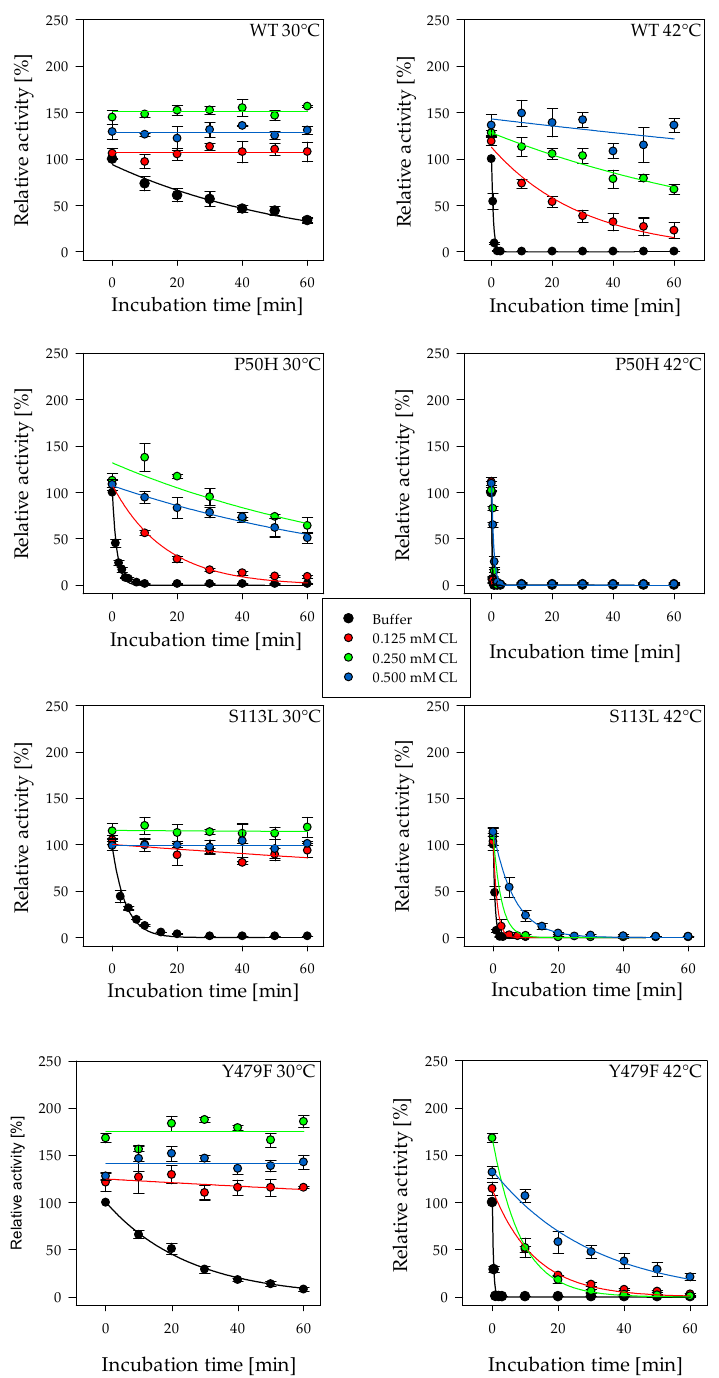
Figure 3. The effect of varying cardiolipin (CL) concentration on the enzymatic activity of recombi- nant CPT II (enzyme concentration 0.1 mg/mL during incubation time) after incubation at 30 and 42 ◦ C. The enzyme assay was started by adding 15 nM enzyme to the reaction mixture. Black symbols represent the relative activity values after incubation with buffer. Red, green and blue symbols represent the relative activity values after incubation with 0.125, 0.25 and 0.5 mM CL, respectively. Enzyme activity was measured at 25 ◦ C as described before [32]. The initial activity value without incubation was set to 100%, respectively. WT, wild type; variants Y479F, S113L and P50H. Error bars are SD derived from three independent experiments. The statistical differences of the maximal enzymatic activities between measurements in buffer or buffer with cardiolipin are indicated as p -values in Tables S3 and